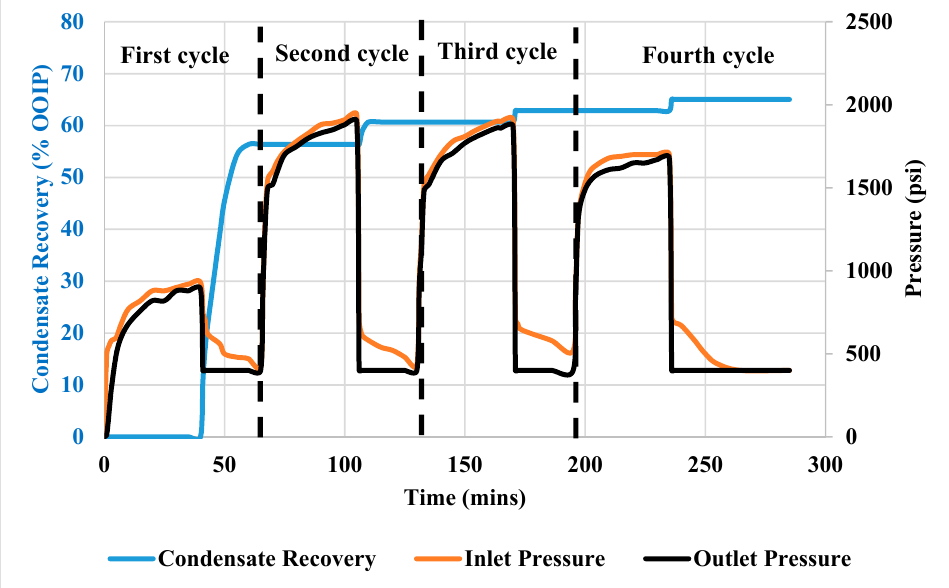
Figure 5. Profiles of condensate recovery, inlet, and outlet pressures for the huff and puff mode. Comparing the two flooding modes, the continuous injection of thermochemical fluids and the huff and puff operations, showed that huff and puff is preferred for condensate treatment. Figure 6 shows the condensate recovery using continuous injection of thermochemical (blue) and the huff and puff mode (orange). Both techniques provided an equivalent condensate recovery, 62.98% and 65.03% were obtained from the continuous and huff and puff modes, respectively. However, less volume of chemicals was used during the huff and puff technique, which will reduce the operational cost. Therefore, the huff and puff mode is more effective than continuous injection in removing the condensate banking. The soaking periods during the huff and puff operations provide more time for the chemicals to react, which improves the performance of thermochemical treatment. Further investigation of the huff and puff process is required to optimize the duration of each cycle and the amount of injected chemicals. Figure 6. Condensate recovery using continuous injection of thermochemical ( Test 1 ) and huff and puff mode ( Test 2 ).